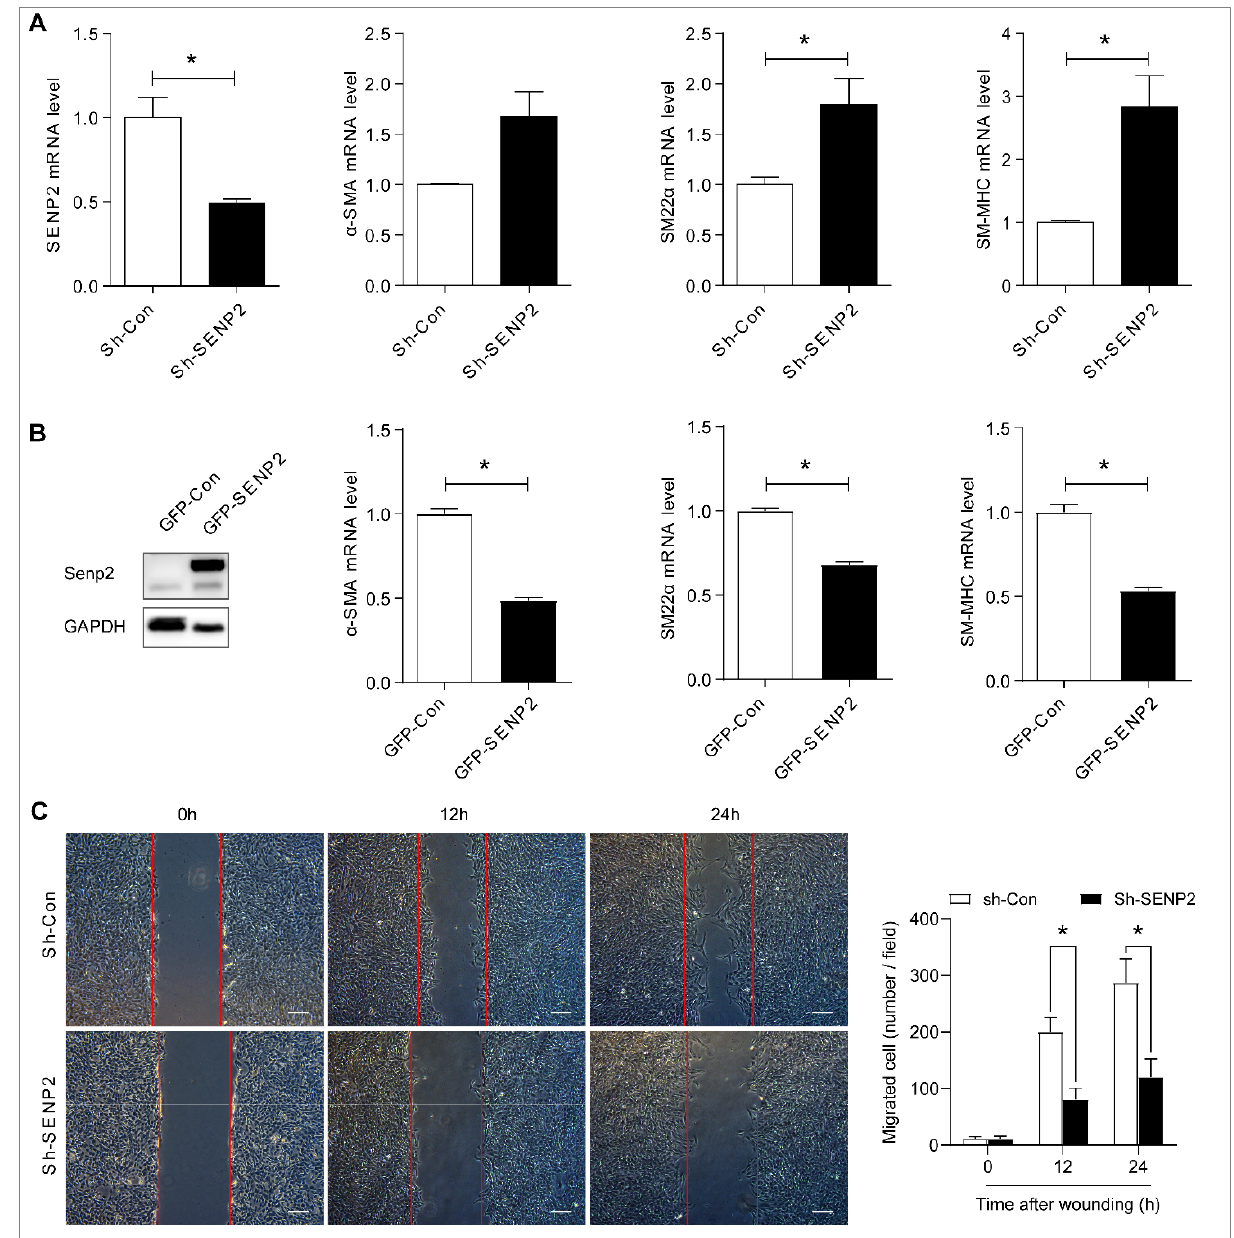
Figure 6. SENP2 promotes VSMC phenotypic switching in vitro. ( A ) VSMCs were infected with control lentivirus (Sh ‐ Con) and sh ‐ SENP2 lentivirus (Sh ‐ SENP2) for 72 h. The expression of SENP2, α‐ SMA, SM22 α , and SM ‐ MHC was examined by real ‐ time quantitative PCR (RT ‐ qPCR). ( B ) VSMCs were infected with adenovirus containing GFP ‐ Con or GFP ‐ SENP2 for 48 h. The expression of SENP2 was examined by Western blotting. The expression of α‐ SMA, SM22 α , and SM ‐ MHC was examined by RT ‐ qPCR. ( C ) VSMCs were infected with control lentivirus (Sh ‐ Con) and sh ‐ SENP2 lentivirus (Sh ‐ SENP2) for 48 h. Monolayer confluent cells were serum ‐ starved overnight and scraped in the presence of normal growth medium to stimulate VSMC migration toward the wound area. Representative images of the in vitro scratch ‐ wound assay and quantification of migrated cells are presented. Scale bars: 200 μ m. A ‐ C , n = 3, * p < 0.05.